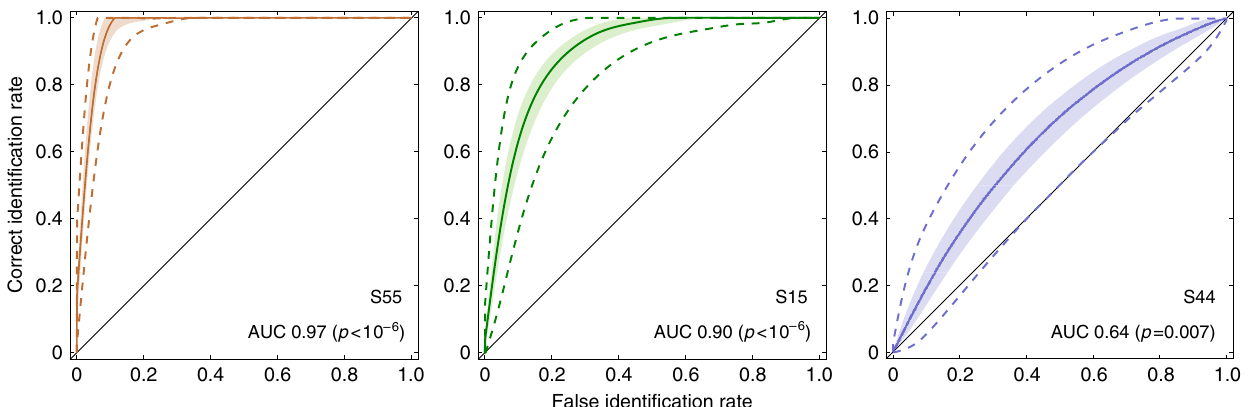
Fig. 8 Signal detection analysis of individual recognition memory for three subjects. Individual recognition ROCs are plotted for the three subjects whose voting functions appear in Fig. 5, matched by color and identi fi ed by subject number. Correct identi fi cation rate, plotted on the ordinate, is derived from analysis of data obtained from the target-present condition for the indicated subject. False identi fi cation rate, plotted on the abscissa, is derived from the simulated target- absent analysis (see Methods) of data obtained from the target-present condition for the indicated subject. As in Fig. 7, shaded regions in each panel contains 50% error of the estimate, and the dashed lines bound a region that contains 95% error of the estimate (equivalent to the 95% con fi dence region; Methods). Each panel also displays the subject identi fi cation number and an estimate of the area under the recognition ROC curve (AUC) at bottom right. The error of estimation of ROC and differences of measures of ROC from chance were computed as described in Methods (section Individual ROC analysis of eyewitness